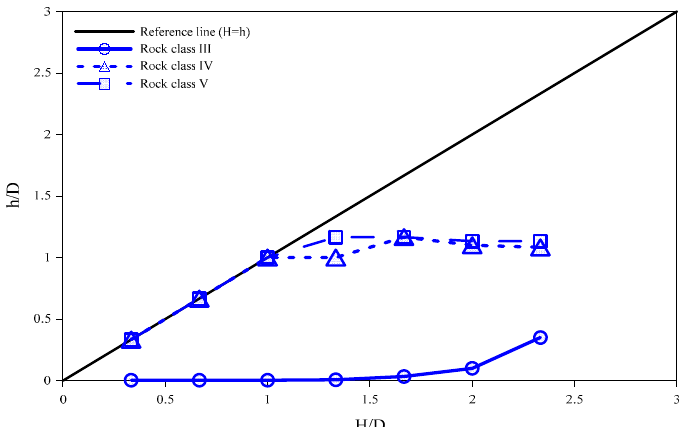
Figure 9. Relation between H / D and h / D from the factor of safety method.